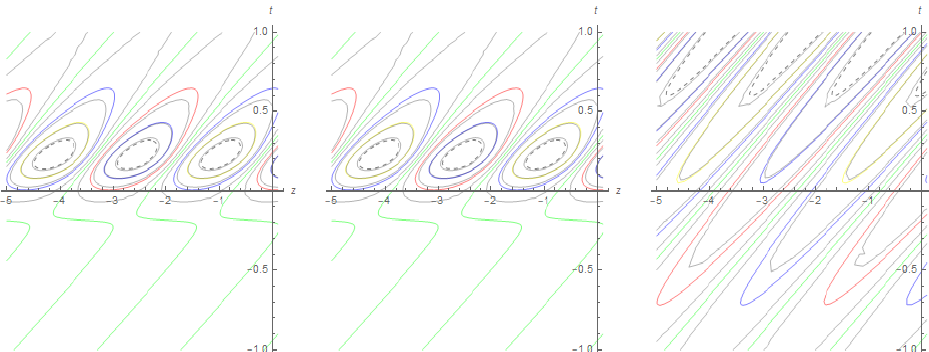
Figure 26. Contour profiles for Figure 25.